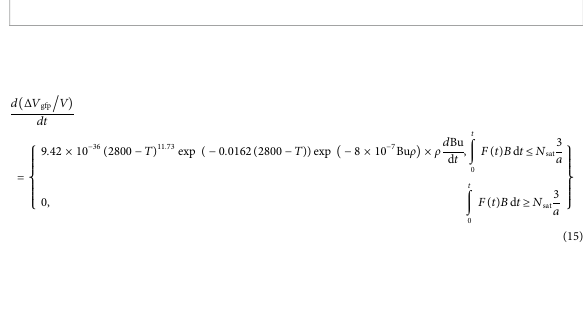
FIGURE 6 Pellet inner surface temperature against burnup for deviation from the stoichiometry of oxygen of 0.001, 0.01, and 0.1 (with Pu content =